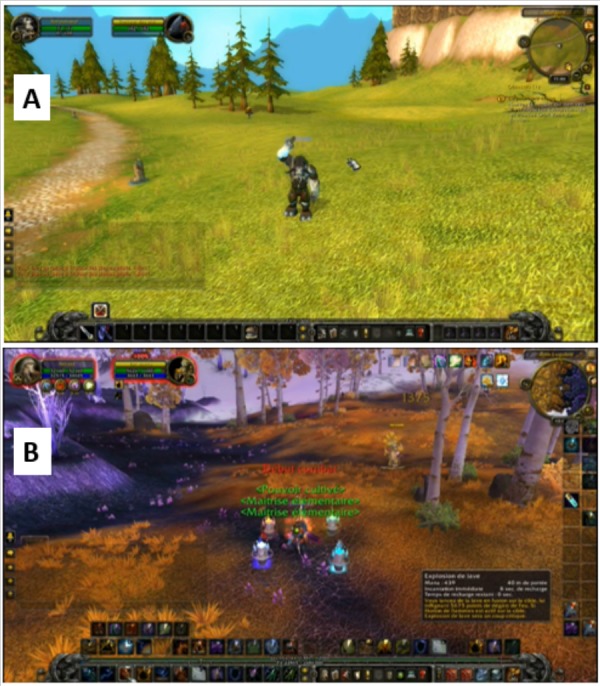
(A) example of a screenshot taken from a simple video consisting of an avatar with less than 10 icons, a simple scenario: “Say hi!” and a simple landscape. (B) example of screenshot taken from a complex video, consisting of an avatar with more than 10 icons, a complex scenario (combat) and a complex landscape.(See also the following online video demo of all the stimuli: https://youtu.be/Kqxm1WkoM5Q.)